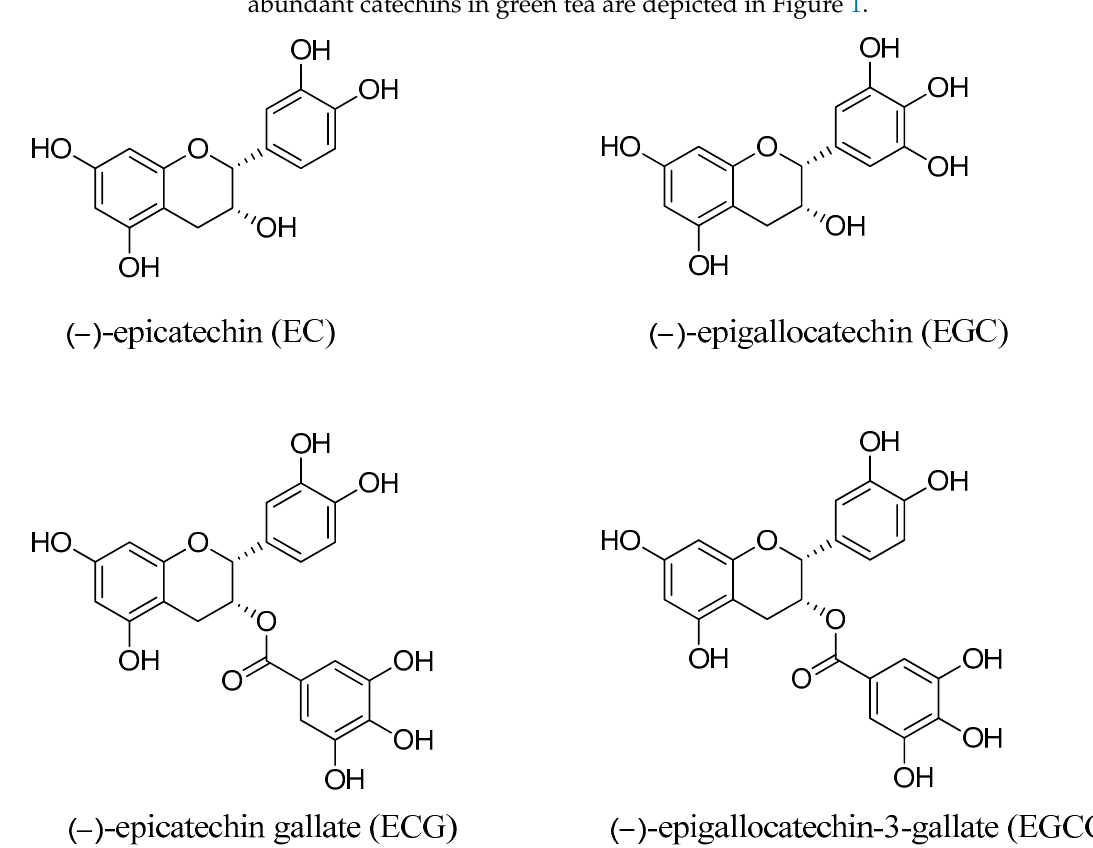
Figure 1. Chemical structure of green tea